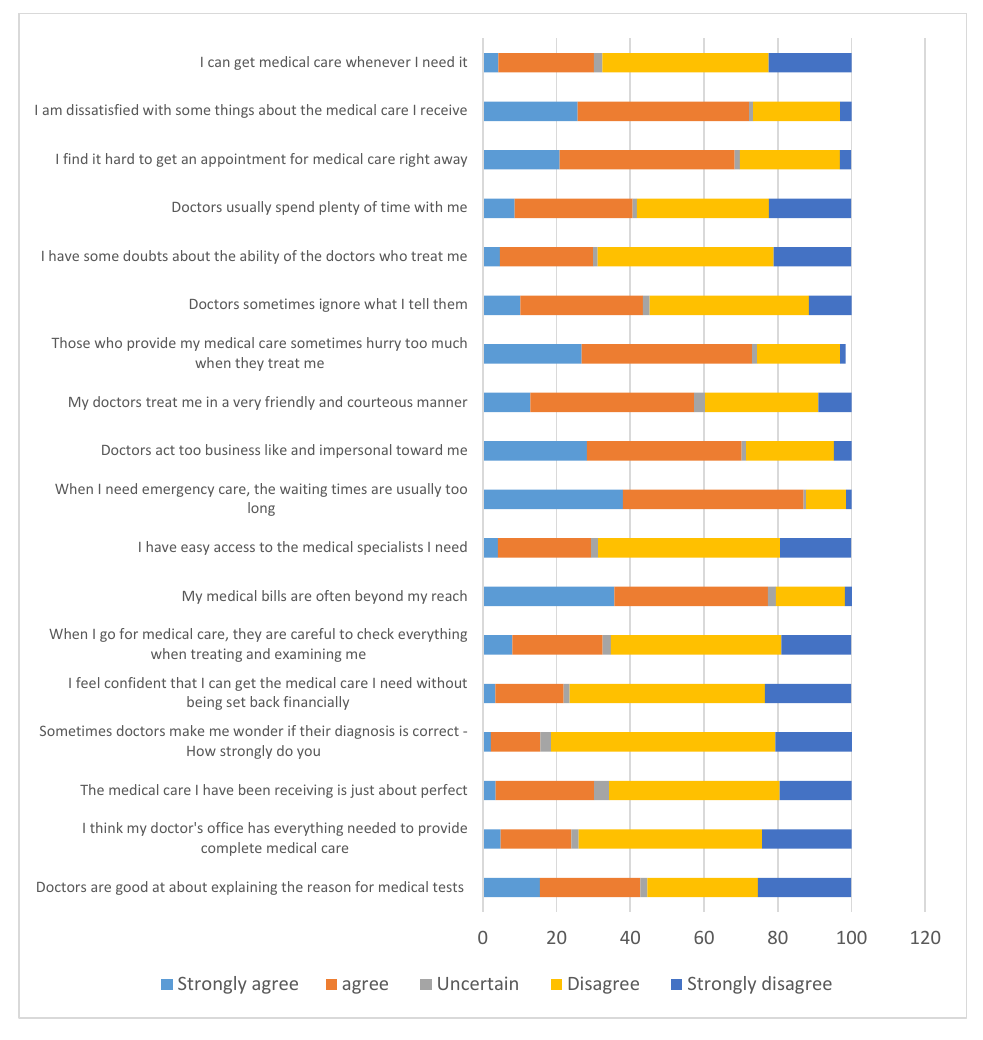
Figure 2. Patient satisfaction with quality of services among older people in Nigeria with multimorbidities.